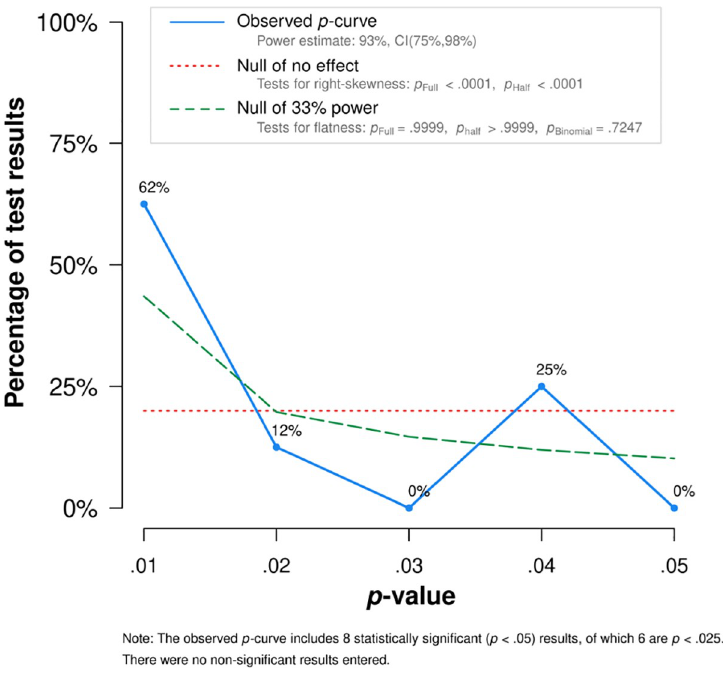
Fig 7. Full p -curve indicating evidential